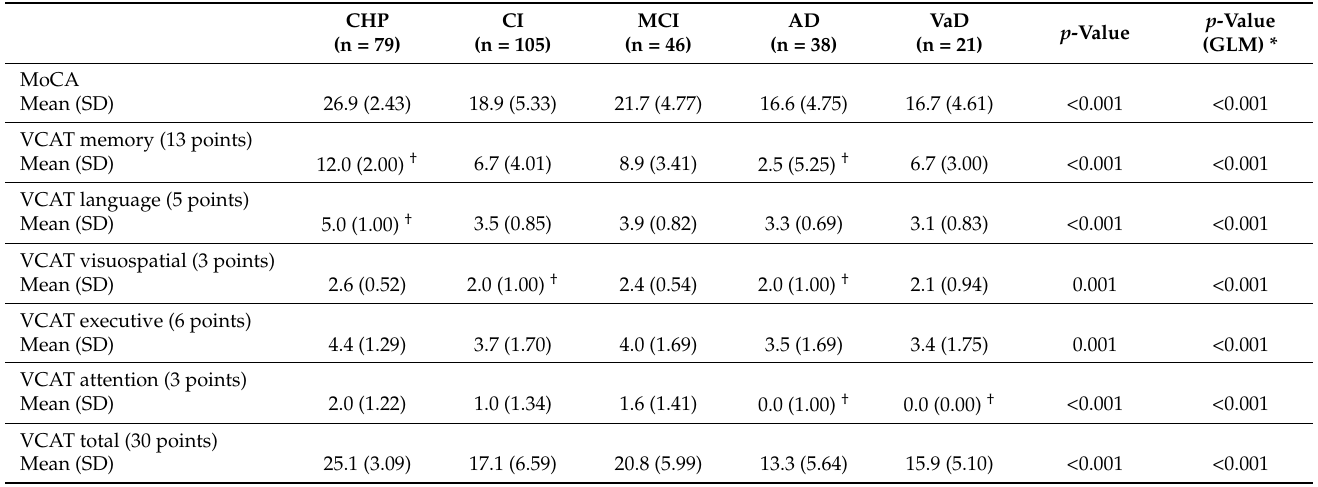
Table 3. VCAT domain and total scores.